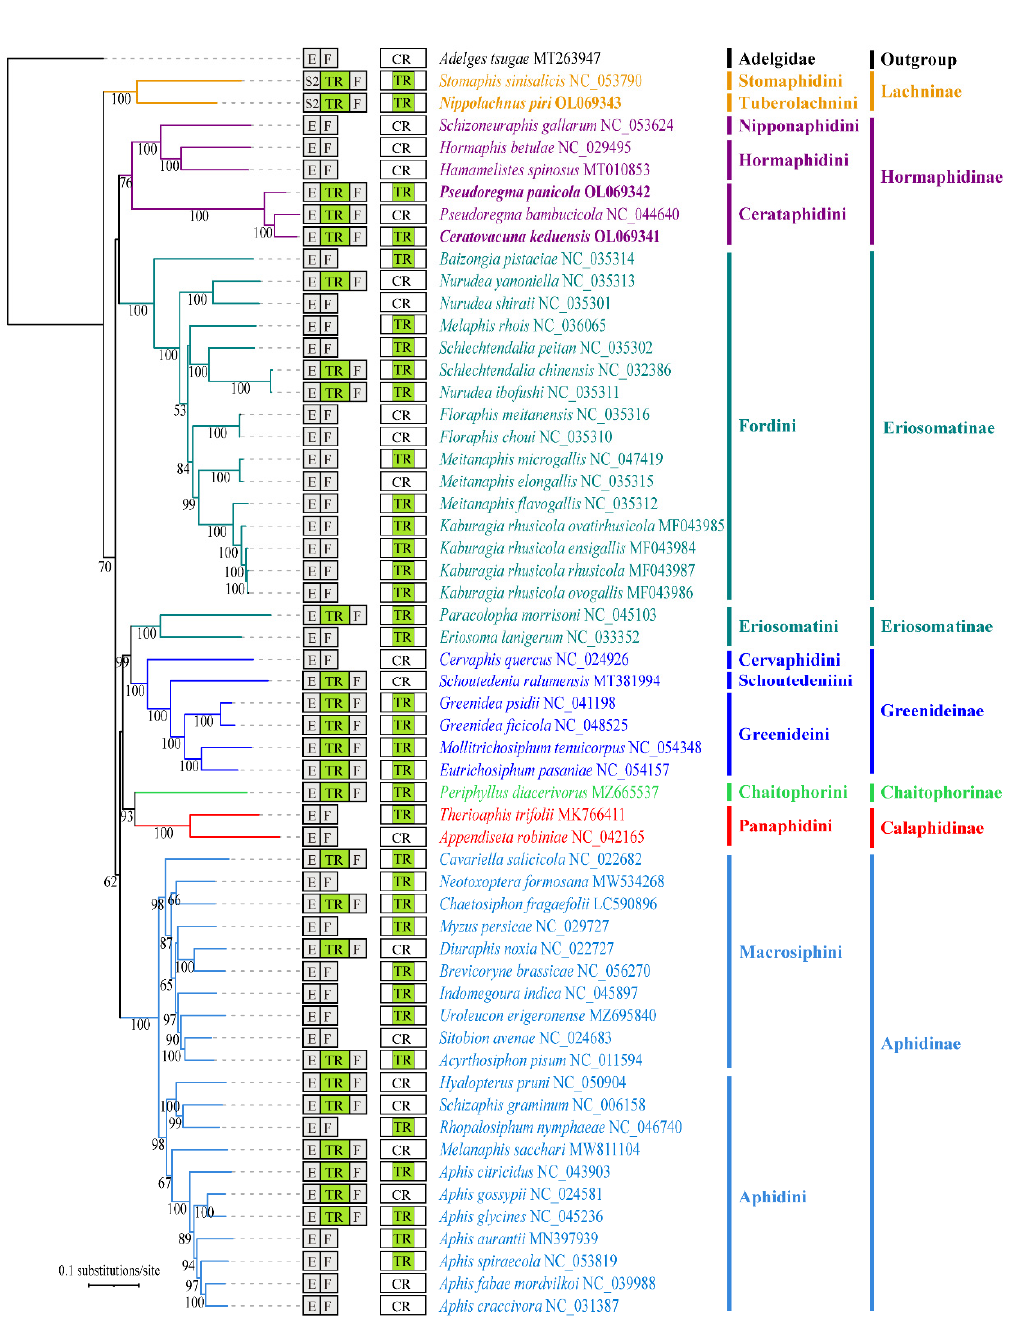
Figure 4. Aphid phylogeny and distribution pattern of tandem repeats in aphid mitogenomes across different clades. Bootstrap support values are indicated by numbers on nodes of phylogenetic tree, and only values > 50% are displayed. Tandem repeats (TR) include repeat sequences between trnE (E) and trnF (F) and those inserted into the control region (CR). “CR” is shown in the figure only if there is no TR in the control region. Different aphid subfamilies are indicated by different colors. Three aphid species in this study are highlighted in bold. S2, trnS2 .